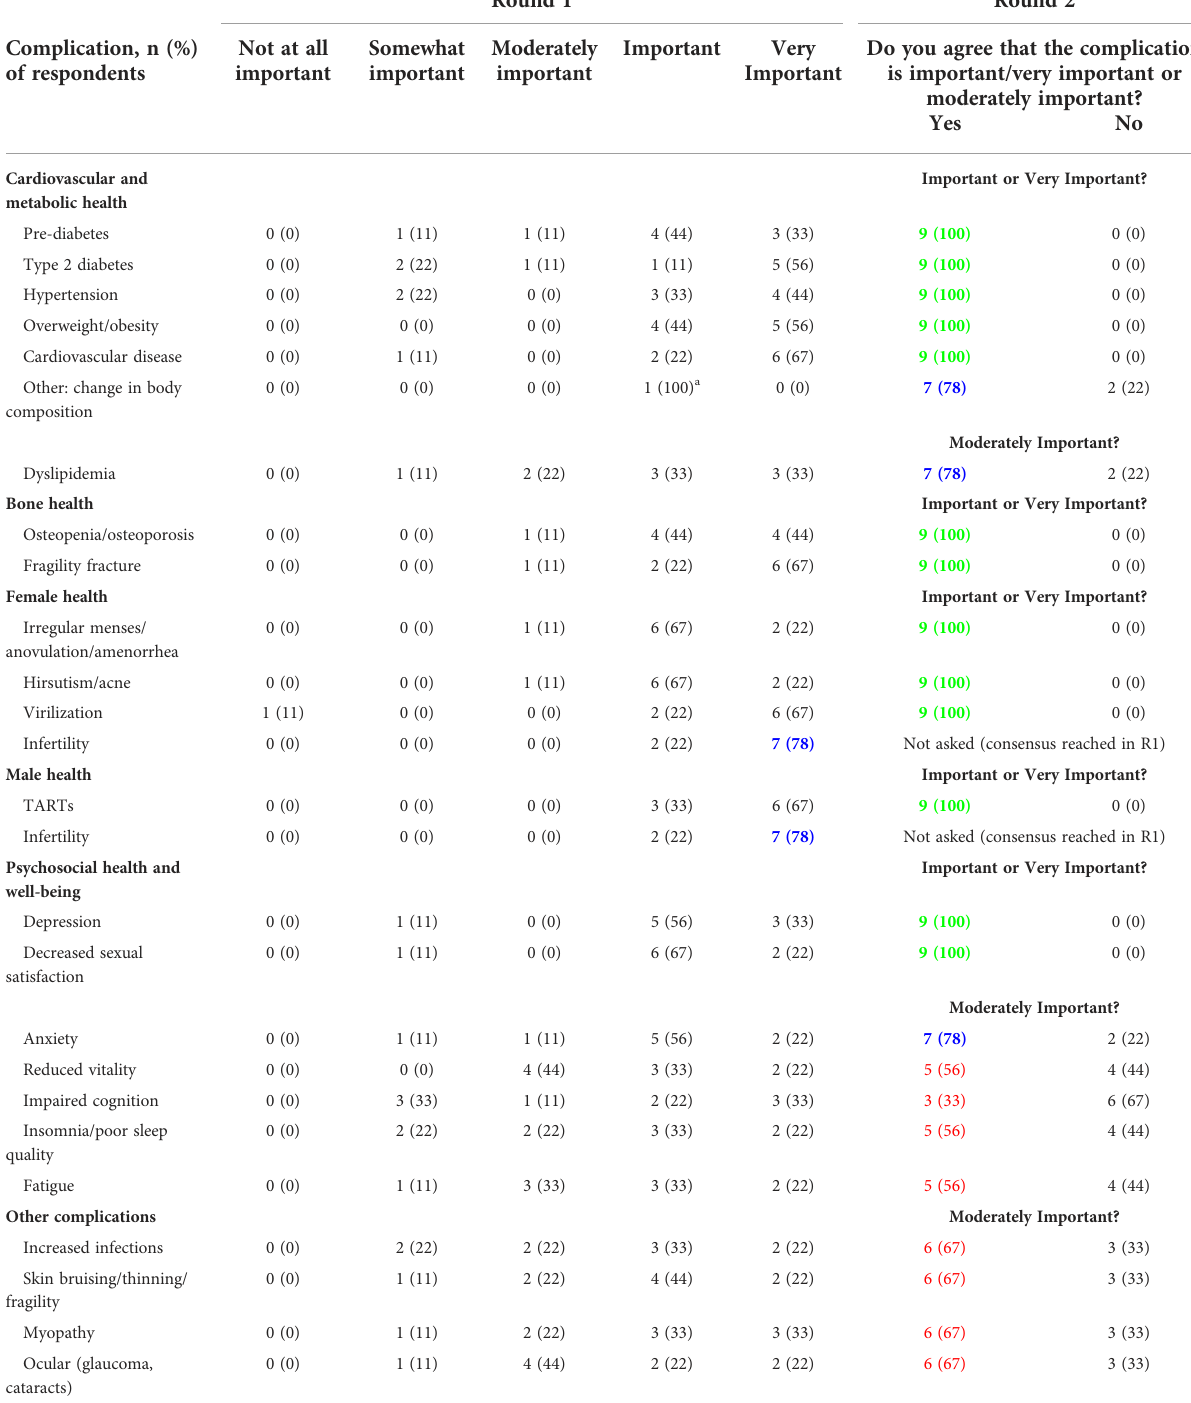
TABLE 2 Importance of disease- or GC-related complications in adults with classic CAH.